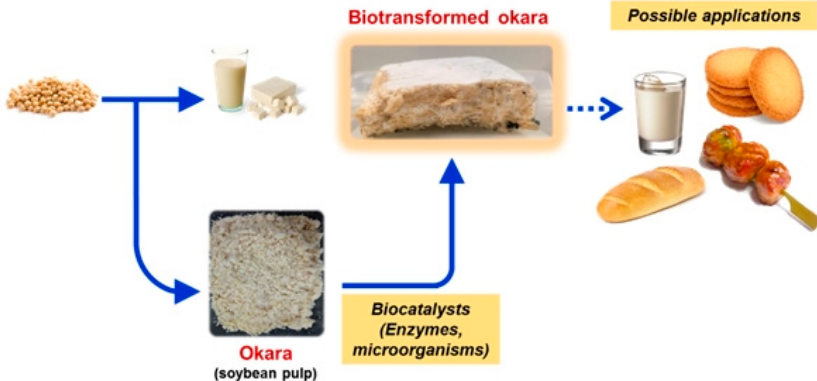
Figure 6. Flowchart illustrating process flow from SB to biotransformed okara, with potential applications in food products (Image credit: Vong Weng Chan) [151].